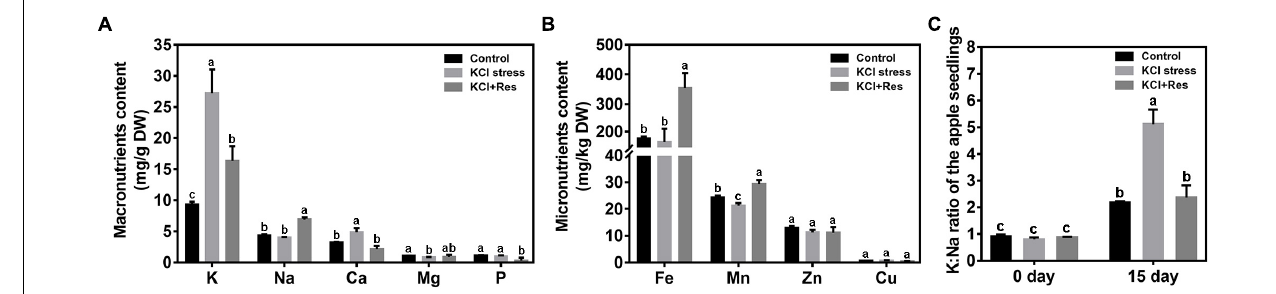
FIGURE 5 | Effects of exogenous Res treatment on macronutrient content (A) , micronutrient content (B) , and K/Na ratio (C) under KCl stress. The data represent the mean ± SD of biological replicates. Different lowercase letters indicate significant differences according to Fisher’s least significant difference ( P <